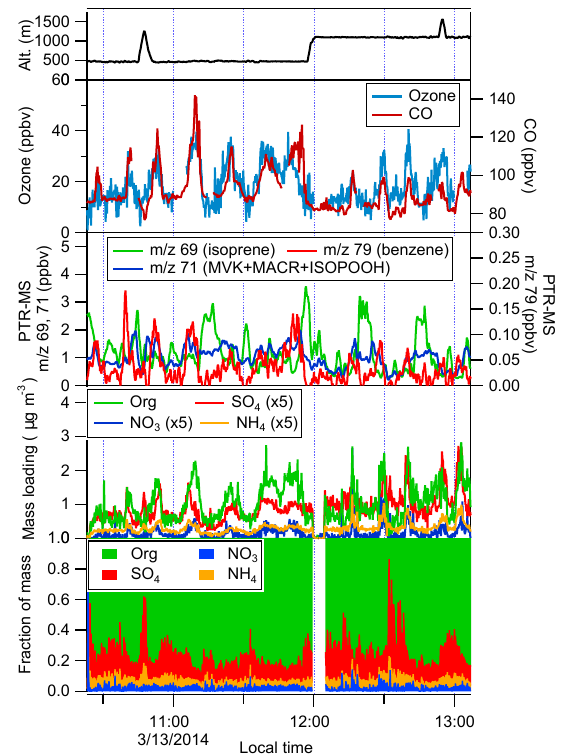
Figure 5. Time traces of relevant plume measurements on the 13 March 2014 flight. Note the mass of inorganic species (SO 4 , NO 3 , NH 4 ) has been multiplied by a factor of 5 to improve the figure clarity. PTR-MS signal at m/z 69 corresponds to iso- prene; m/z 71 corresponds to the sum of methyl vinyl ketone (MVK), methacrolein (MACR), and isoprene hydroxyhydroperox- ide (ISOPOOH), all oxidation products of isoprene; and m/z 79 corresponds to benzene. AMS data are normalized to 23 ◦ C and